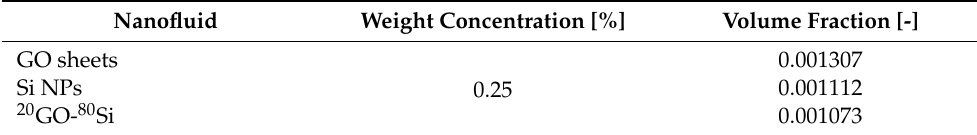
Table 3 defines the volume fractions for all of the studied mono-hybrid nanofluids. Table 3. The volume fractions of the